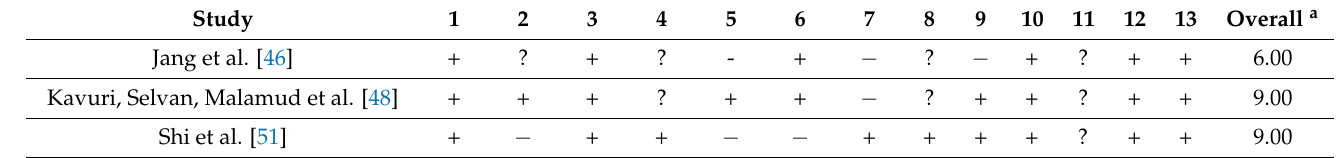
Table 6. Results of JBI Critical Appraisal for Randomized Controlled